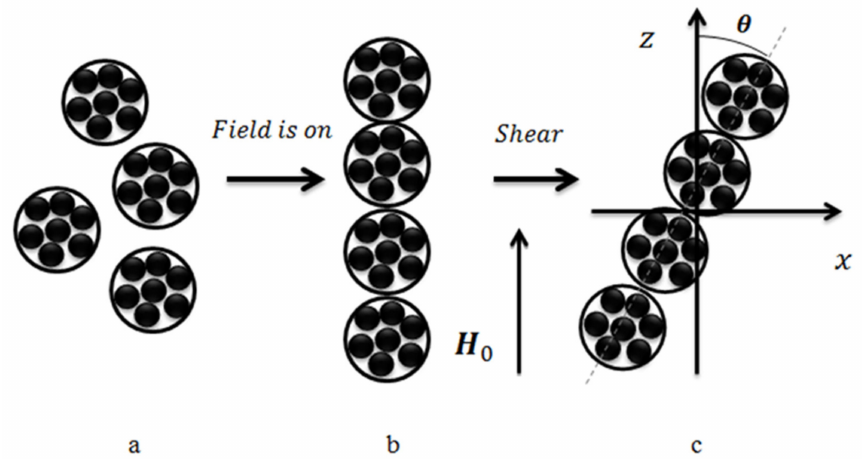
Figure 10. Sketch of the model system: ( a ) isotropic distributed spherical-shaped agglomerates; ( b ) agglomerates united into a linear chain aligned along an externally applied field; ( c ) deviation of the chain from the field direction under macroscopic shear